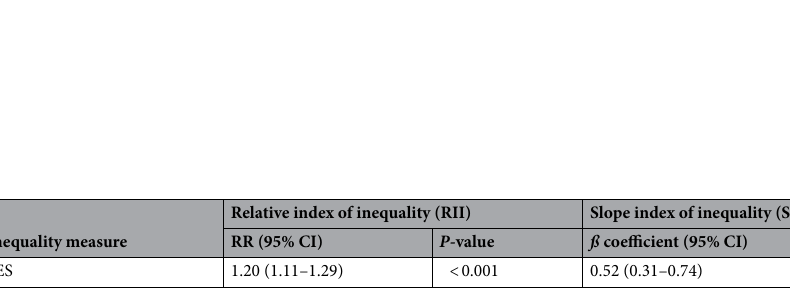
Table 3. Summary measures of SES and the CoC across the women’s reproductive life cycle: Bangladesh Demographic and Health Survey 2017–18 (n = 1527). Note: CI = confidence interval; RR = risk